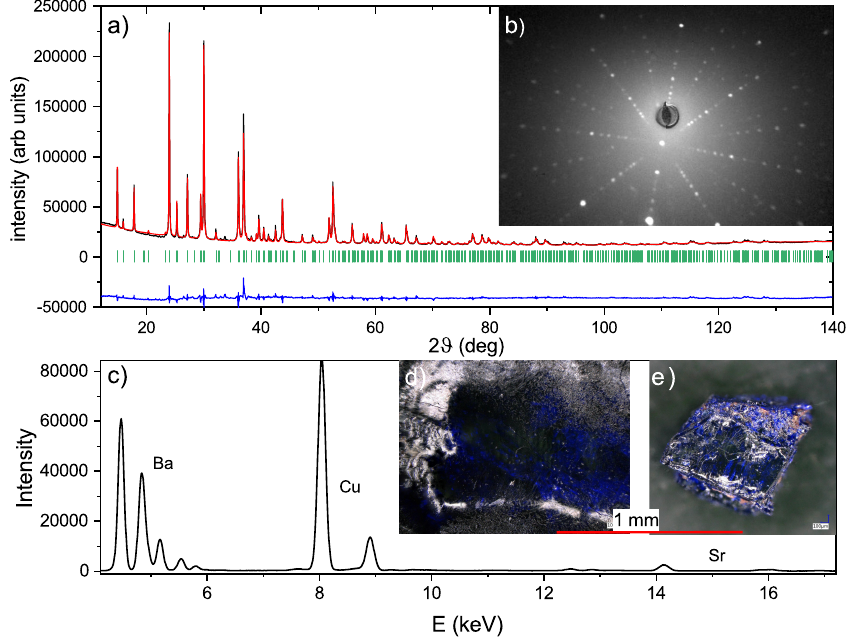
Figure 4. ( a ) Rietveld refinement of the crystal structure parameters of Ba 0.9 Sr 0.1 CuSi 2 O 6 crushed single crystals, based on laboratory X-ray powder diffraction data at 295K. The rows of ticks in the middle correspond to the calculated diffraction peak positions of the I 4 1 / acd structure. ( b ) Laue image on the shiny side of the single crystal shown in Figure 5b revealing the c -axis of the tetragonal system. ( c ) MicroXRF spectra of the Ba 0.9 Sr 0.1 CuSi 2 O 6 single crystal C8. ( d ) Magnified image of a section from the FZ crystal C8 ( e ) Broken piece of an FZ grown crystal solely in oxygen atmosphere